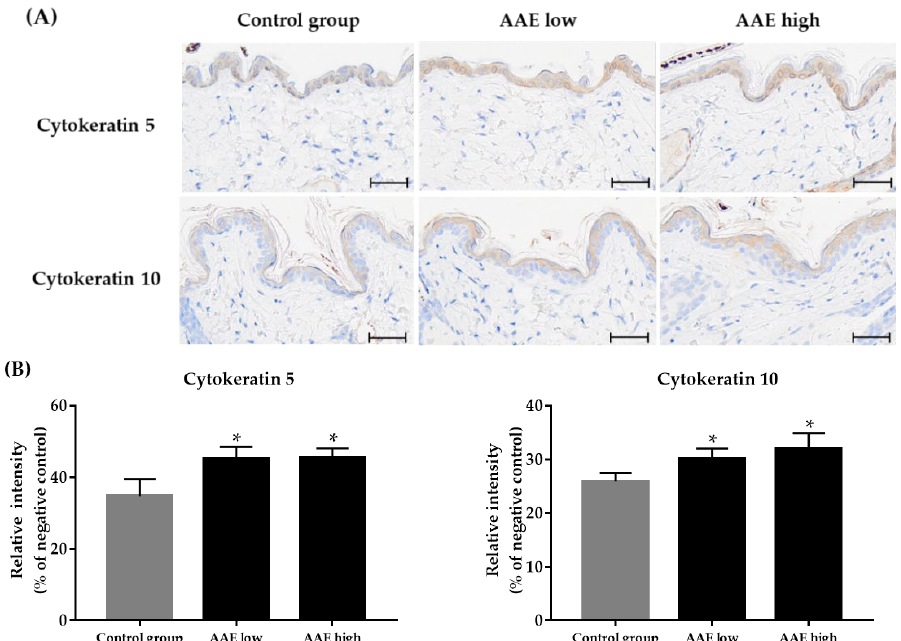
Figure 4. Comparison of expression of Cytokeratin 5 and 10 using immunohistochemistry ( A ) Digital photomicrographs were taken from areas at a fixed magnification of 400 × . Scale bars on tissue slides indicate 20 µ m. The stained area of the Cytokeratin 5 and 10, relative to the entire epidermis (%), was significantly increased in both AAE-treated groups compared to in the control ( B ). * p < 0.05 compared with the control